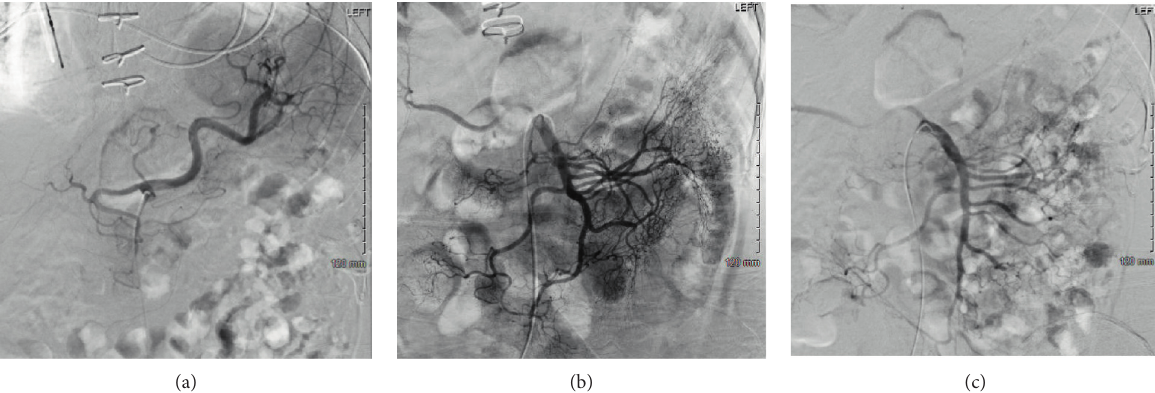
Figure 2: Interventional radiology completed angiography of the celiac (a), superior mesenteric (b), and inferior mesenteric (c) during arterial embolization. 300 to 500 micron PVA particles were used to embolize an AVM in the